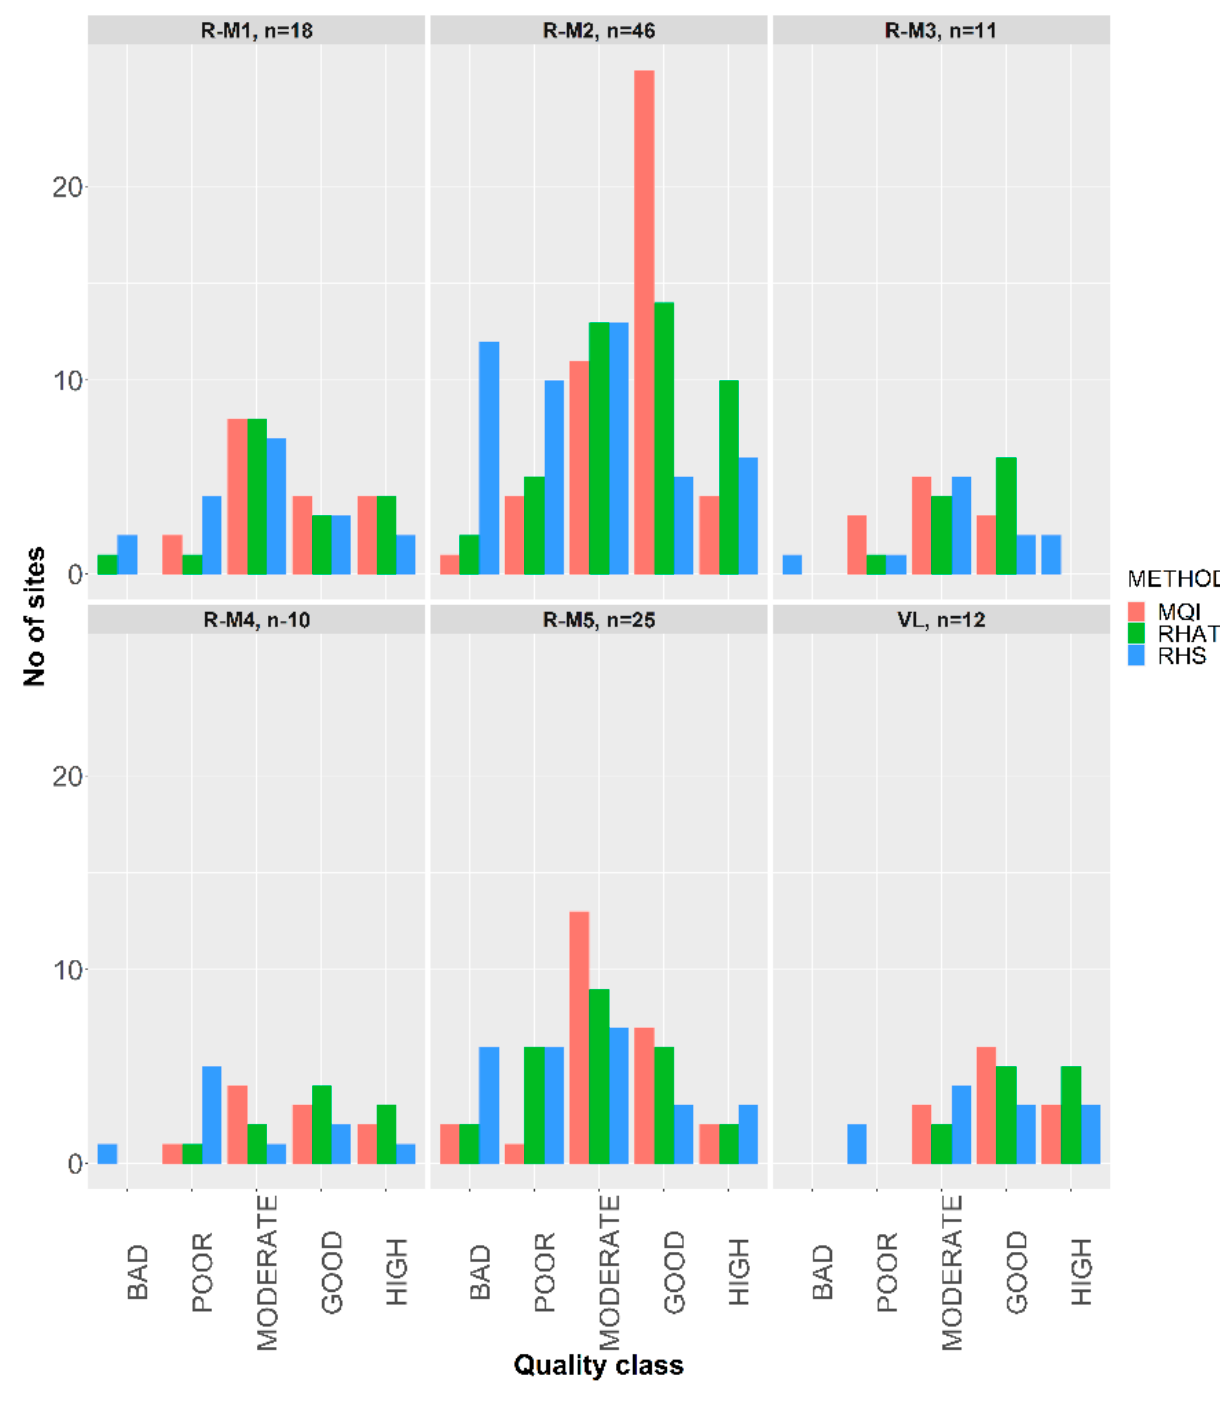
Figure 5. Distribution of quality classes defined by the three assessment methods for each intercali- bration river type (ICT).